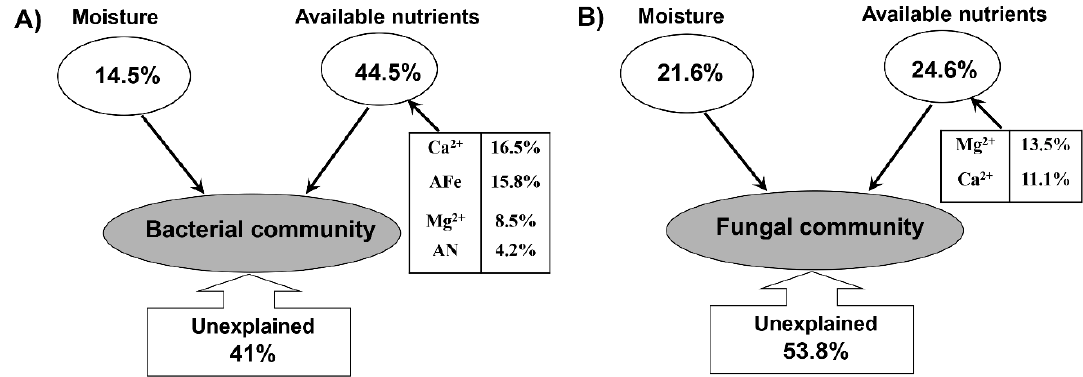
Figure 10. Variation partition analysis (VPA) of the effects of soil moisture and available nutrients on soil bacterial ( A ) and fungal ( B ) communities in Stropharia rugosoannulata cultivation areas.